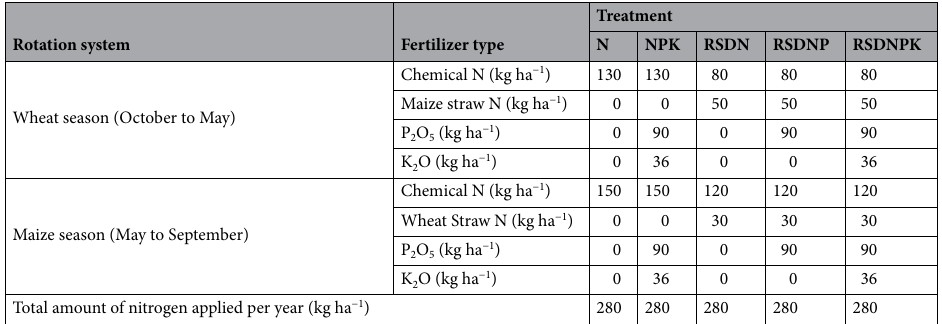
Table 2. Details of the fertilizer application in the experiment. N synthetic N fertilizer, NPK synthetic fertilizer: nitrogen, phosphorus and potassium, RSDN crop residues returned with nitrogen, RSDNP crop residues returned with nitrogen and phosphorus and RSDNPK crop residues returned with nitrogen, phosphorus and